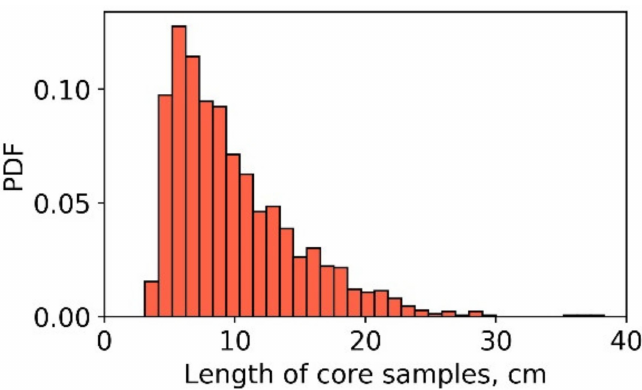
Figure 2. Distribution histogram for the length of full-sized cores under